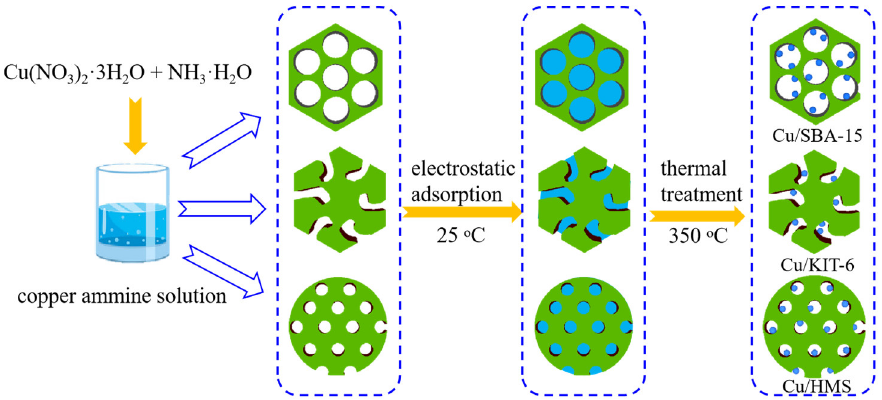
Figure 1. Schematic illustration for the synthesis of Cu/SBA-15, Cu/KIT-6, and Cu/HMS